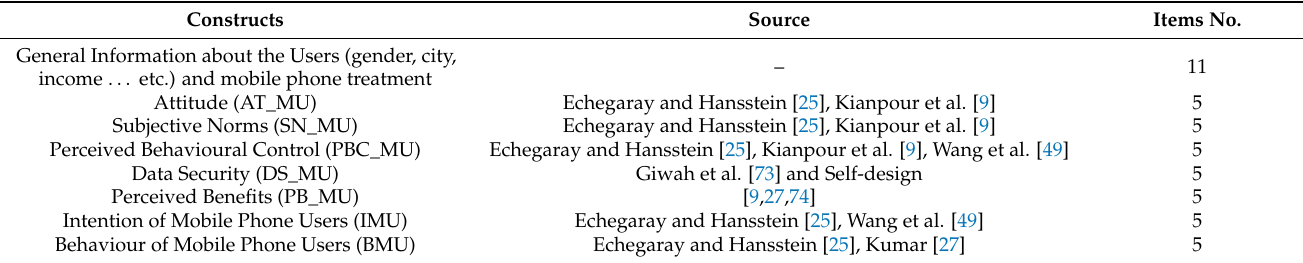
Table 1. List of studies used for the survey questionnaire.